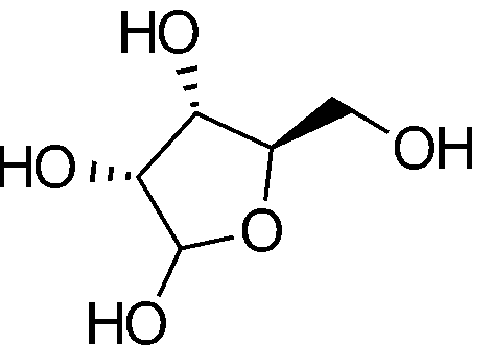
Figure 3. Ribose ( β -D-ribofuranose). Numbering code: first carbon on the left of the oxygen atom is C1. Last position in the five-ring is C4. The carbon in the side branch is C5.